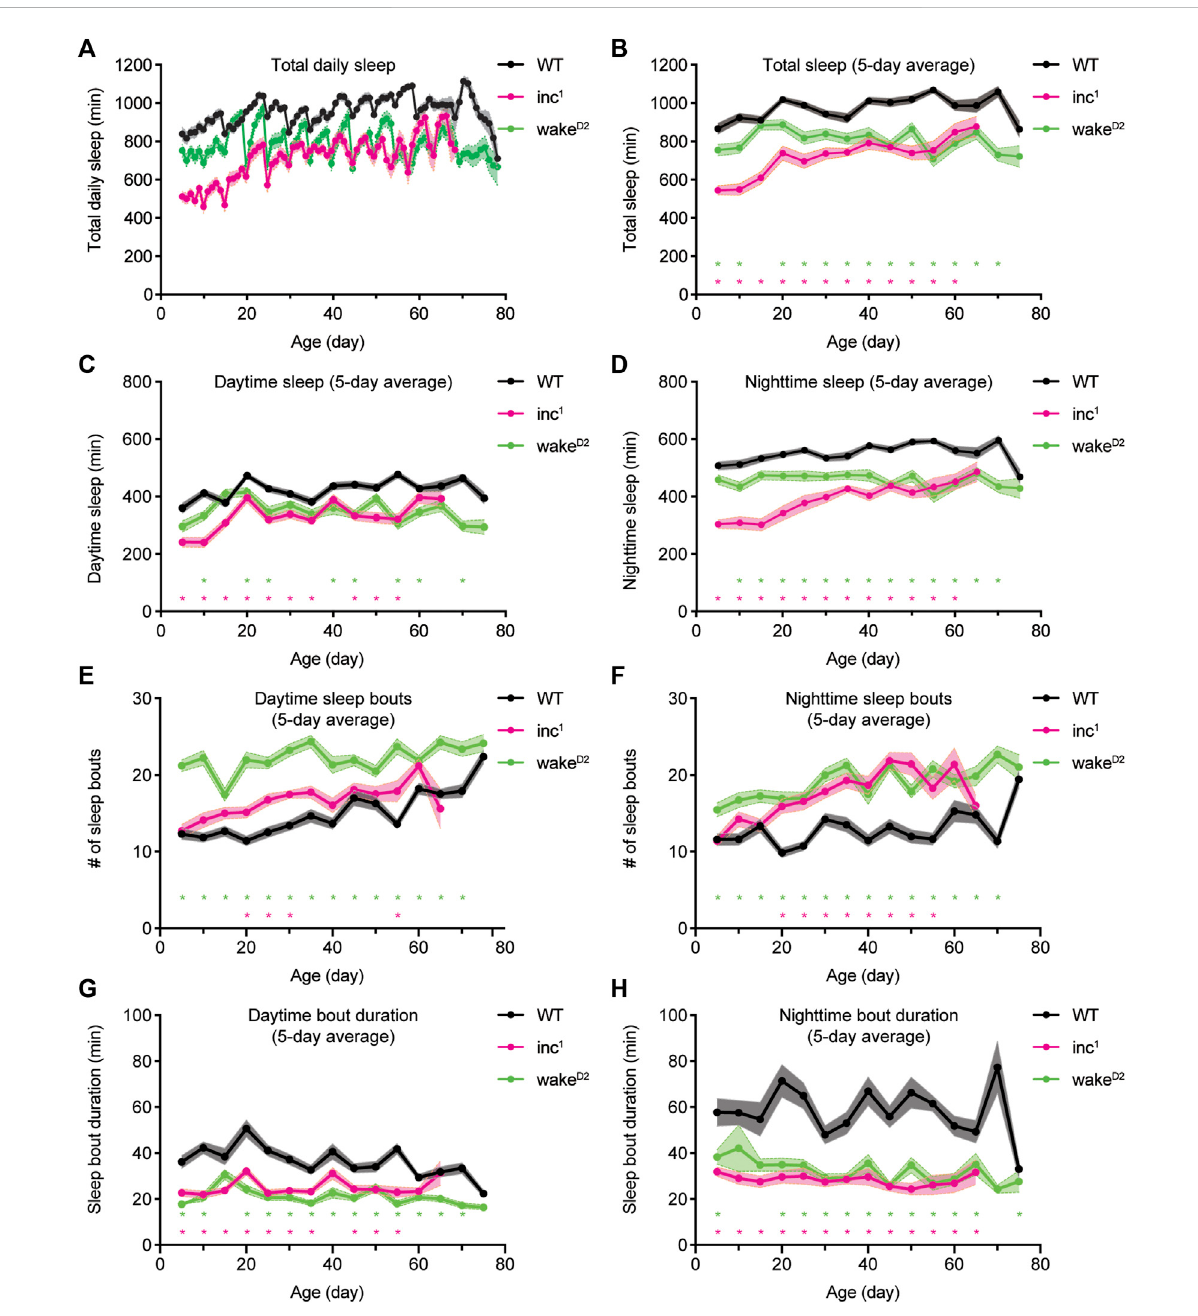
FIGURE 1 Chronic and consistent sleep loss in sleep mutants inc 1 and wake D2 . (A) Average total sleep per day for WT (black), inc 1 (magenta), and wake D2 (green)male fl iesoverlifetime. (B – D) 5-dayaveragetotalsleepperday (B) ,averagedaytimesleep (C) ,andaveragenighttimesleep (D) for WT (black), inc 1 (magenta),and wake D2 (green) male fl ies over lifetime. Each data point represents fl ies of corresponding age that were loaded and measured for sleep over 5 consecutive days. Data collected from different loadings are connected by solid line. (E,F) Average number of daytime sleep bouts (E) and nighttime sleep bouts (F) for WT (black), inc 1 (magenta), and wake D2 (green) male fl ies over lifetime. (G, H) Average duration of daytime sleep bouts (G) and nighttime sleep bouts (H) for WT (black), inc 1 (magenta), and wake D2 (green) male fl ies over lifetime. Mean ± SEM is shown. n = 26 – 32 for WT , n = 4 – 32 for inc 1 , n = 11 – 32 for wake D2 . * p < 0.05; multiple t tests with Holm-Sidak correction against same-age WT fl